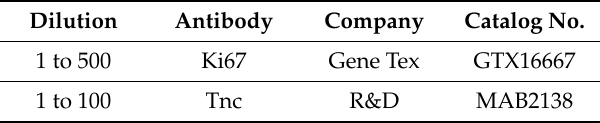
Table 3. Primary antibodies used for